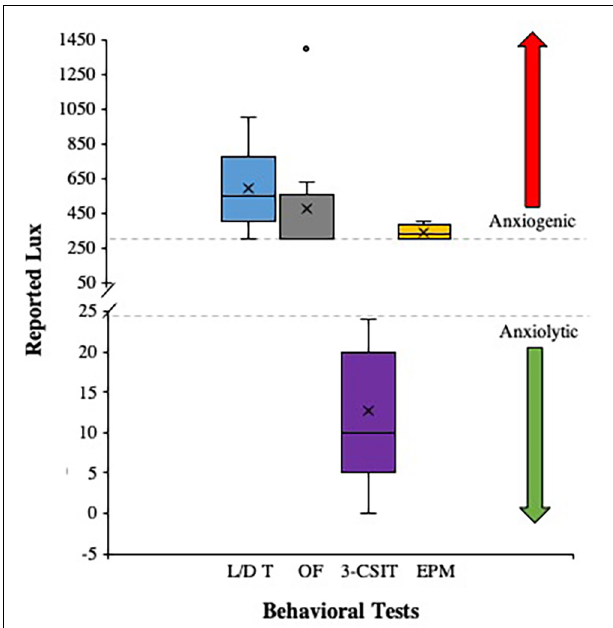
FIGURE 3 | This figure illustrates the number of publications that met the criteria for ethologically relevant use of light stimuli (Lux) reported for the Light/Dark Test (L/D T), Open Field Test (OF), the Three Chamber Social Interaction Test (3-CSIT), and the Elevated Plus Maze Test (EPM). The data are presented as Box and Whisker Plots where the mean is represented as (X) the median represented as the line within the boxes (-), the inter-quartile ranges ( IQRs ) are represented as the lower portion of the whisker to the box ( IQR 1 ), the lower box to the median ( IQR 2 ), the median to the upper box ( IQR 3 ), and the upper box to the upper whisker ( IQR 4 ). The figure also shows a gray dashed line at 300 Lux indicating a threshold for anxiogenic behaviors that occur with light stimuli above this value (red arrow), whereas anxiolytic behaviors occur with light stimuli below the 25 Lux gray dashed line (green arrow). There was one reported outlier for the OF with a Lux of 1,400 reported, otherwise the L/D T, OF, and EPM for the studies that met criteria used comparable Lux as an anxiogenic stimulus range and the 3-CSIT Lux reported were within the anxiolytic stimulus range.